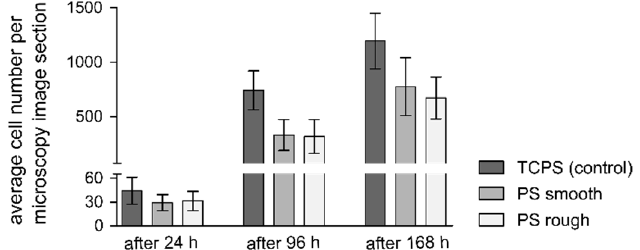
Figure 7. Average number of L-929 cells per image section after culture for 24 h ( left ), 96 h ( middle ) and 168 h ( right ) on TCPS (dark grey) and FDM-printed PS substrates (light grey: smooth surfaces, white: rough surfaces). The cell number was assessed by the counting of Hoechst-stained cells. For the cultivation periods of 24 and 96 h, 1 × 10 4 cells per well and for the cultivation period of 168 h, 2 × 10 3 cells per well were seeded. Three independent experiments were carried out in triplicate. Four images per sample were taken (36 per condition per time point). Error bars represent the standard deviation.